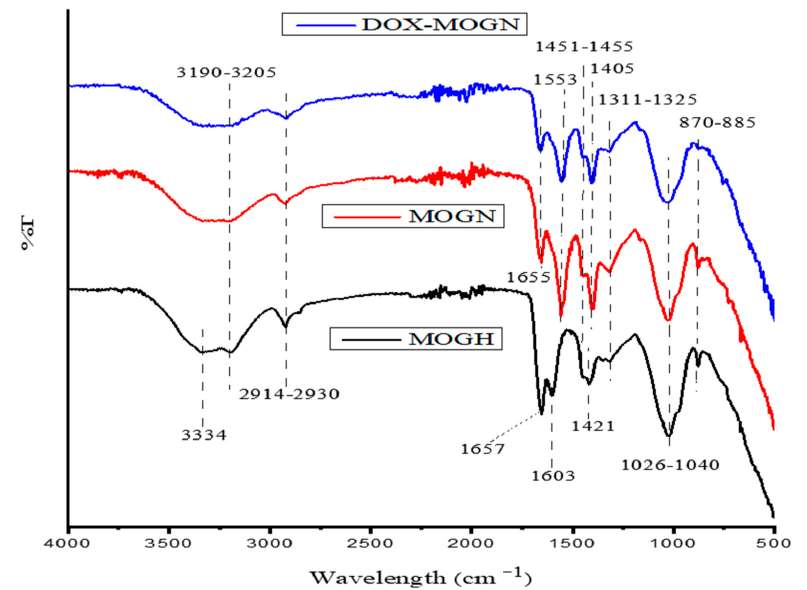
Figure 1. FTIR spectra of MOGH, MOGN, and DOX–MOGN.